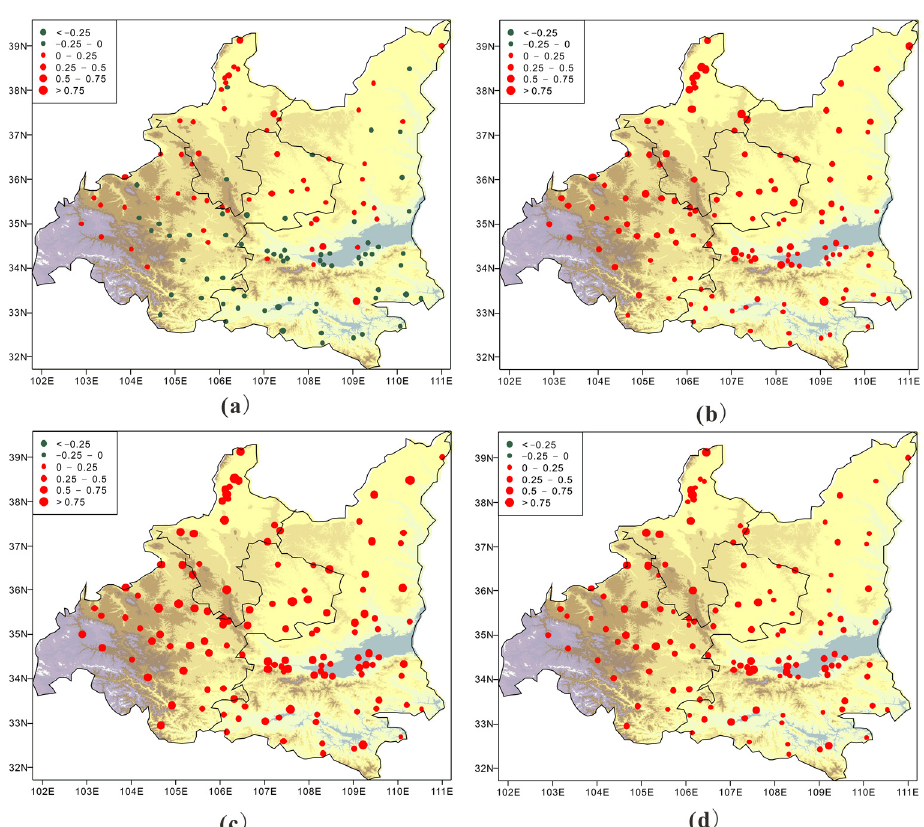
Figure 5. Spatial distribution of temperature change rate in different periods (unit: °C/10 years): ( a )